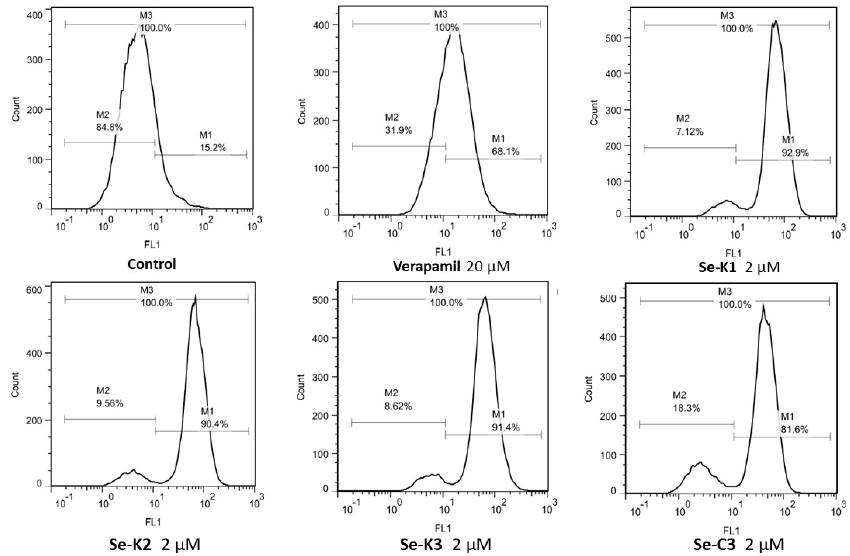
Figure 1. Inhibition of ABCB1 in Colo 320 cells by ketone selenoesters (Se-K1, Se-K2, Se-K3) and cyano-selenoester Se-C3. FL1: fluorescence; Count: number of cells.